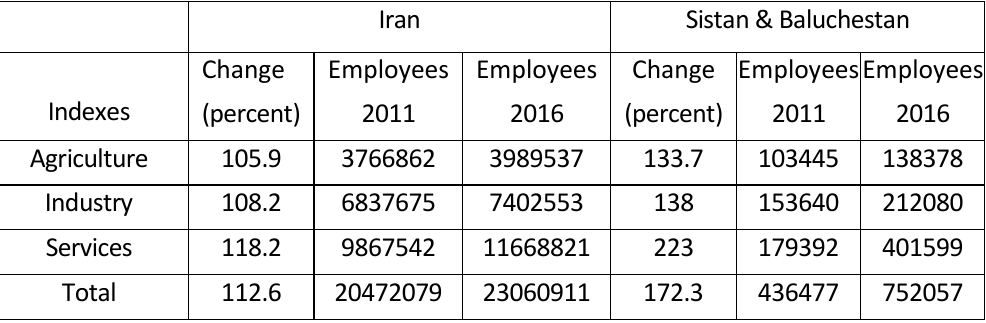
Table 5: The changes in the economic sectors of Sistan & Baluchestan in the Izard model